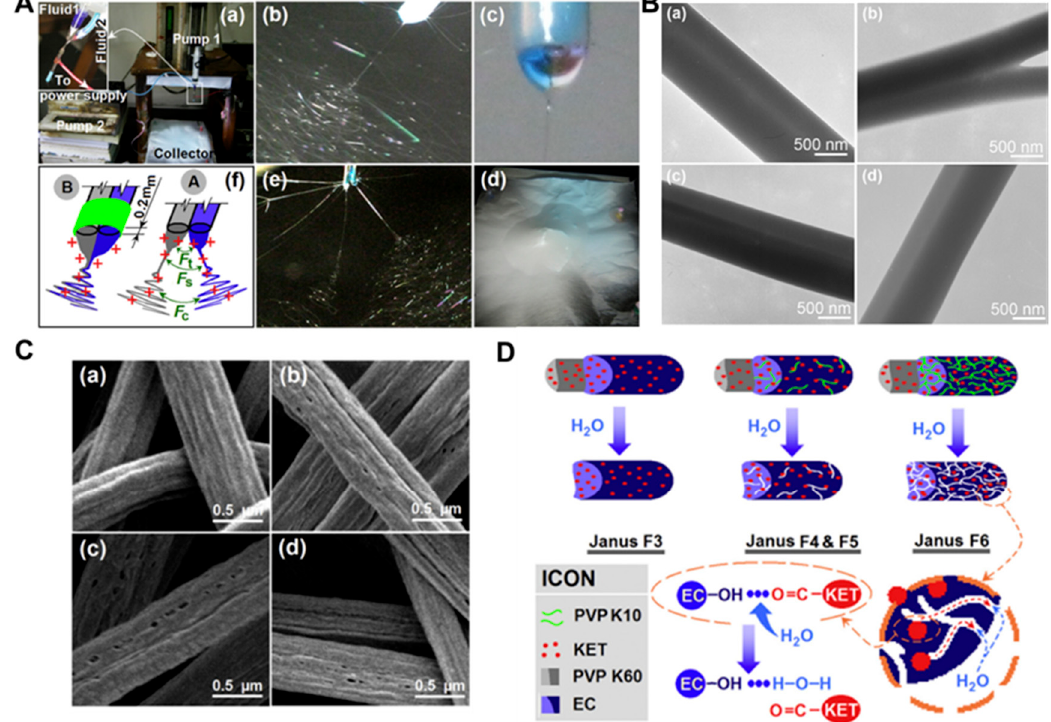
Figure 10. Fabrication, morphology, and mechanism of side-by-side structures. ( A ) Side-by-side electrospinning process: (a) experimental apparatus (inset: connection of side-by-side spinneret with the working fluids and power supply); (b) a photograph of a typical side-by-side electrospinning process with the Teflon-coated spinneret; (c) a Janus Taylor cone formed with the Teflon-coated spinneret; (d) fiber mat from side-by-side electrospinning with uncoated side-by-side spinneret; (e) the separation of fluids when using the uncoated spinneret; (f) an illustration of the role played by the Teflon coating: A—the separation of fluids arising from repulsive forces Ft (between the two Taylor cones), Fs (between the two straight fluid jets). ( B ) TEM images of (a) F3; (b) F4; (c) F5; (d) F6 and Fc (between the two coils); and B—the formation of an integrated Janus Taylor cone with the Teflon coating. ( C ) Field emission scanning electron microscope (FESEM) images of the fibers remaining after 24 h of dissolution and the proposed drug release mechanism. (a–d) show the remains of fibers F3–F6 respectively; ( D ) is a schematic diagram explaining the mechanism of drug release from the Janus fibers. Reproduced from [236] with permission from Elsevier Ltd.; Copyright 2016.